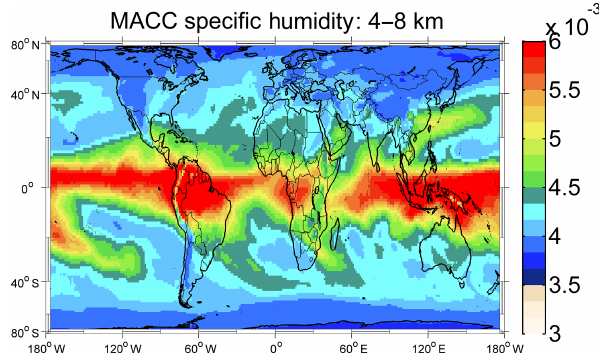
Figure A2. Same as Fig. 12 but for the year 2010.